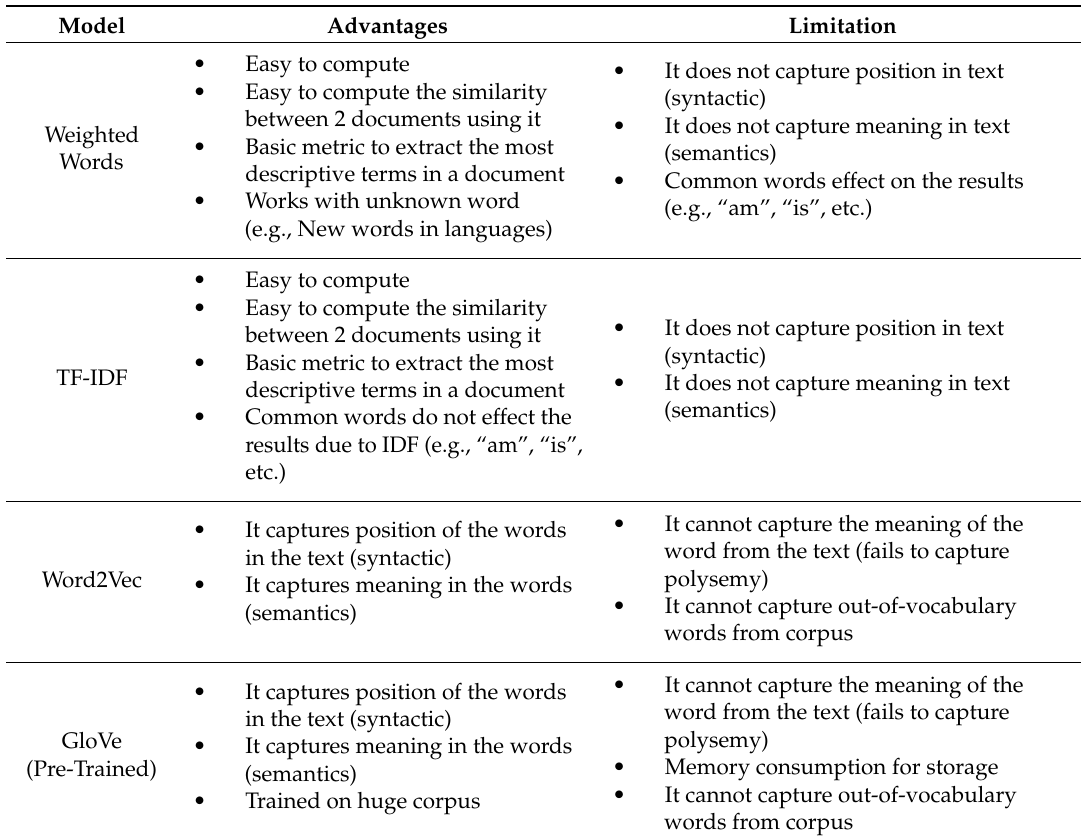
Table 1. Feature extraction